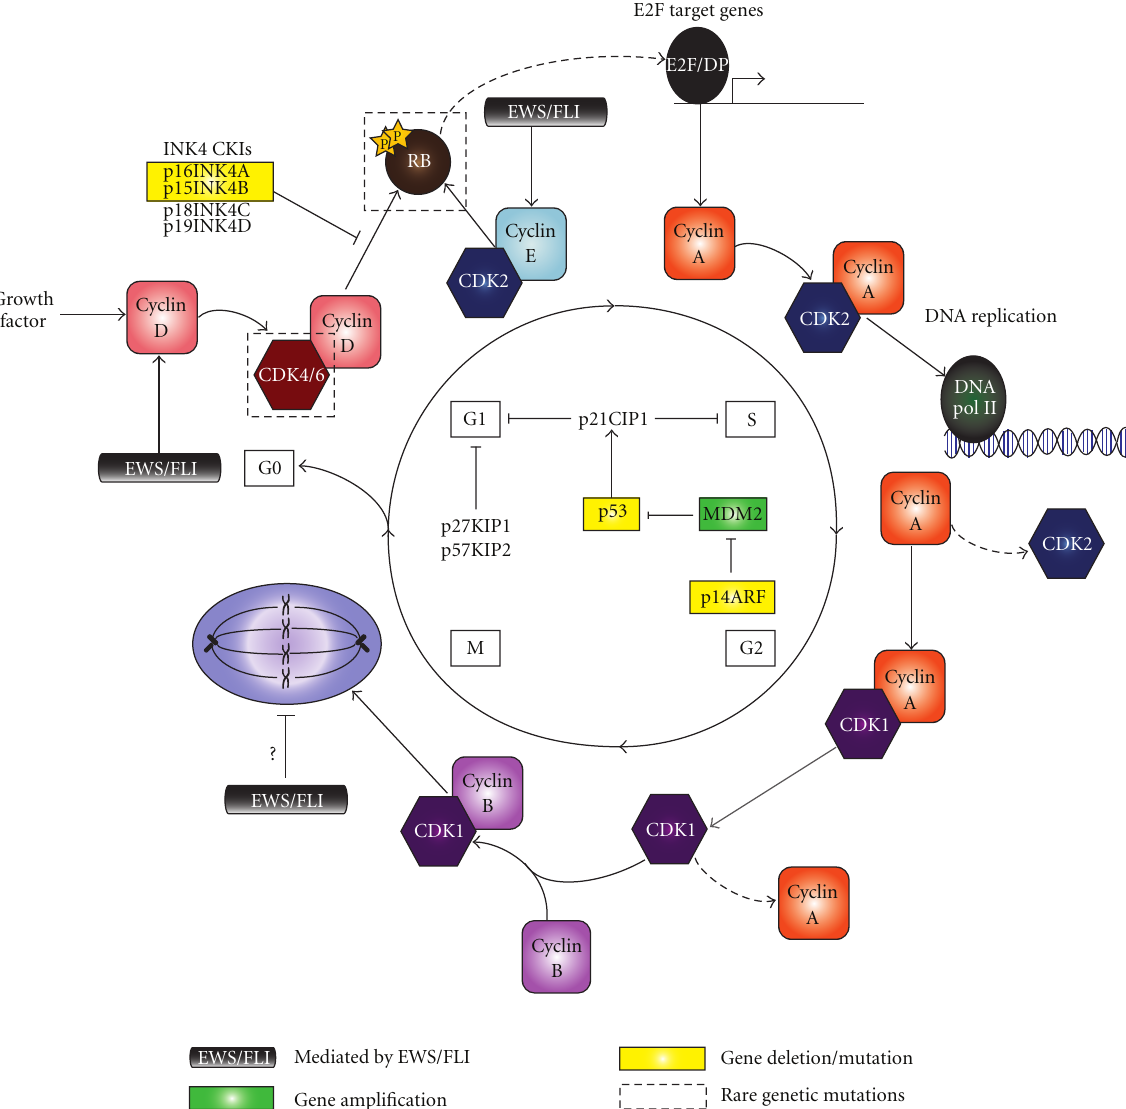
Figure 1: Overview of the cell cycle. Progression through the cell cycle is mediated by cyclin-CDK complexes that regulate RB function. Cyclin-dependent kinase inhibitors negatively regulate this process in order to control DNA replication and cell division. Based on the data presented above, regulators of the cell cycle thought to be involved in Ewing’s sarcoma pathogenesis are indicated. (Note: in an e ff ort to be concise, only the most significant regulators and their respective functions are included in the